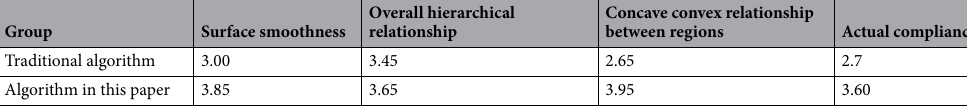
Table 4. Quantitative score